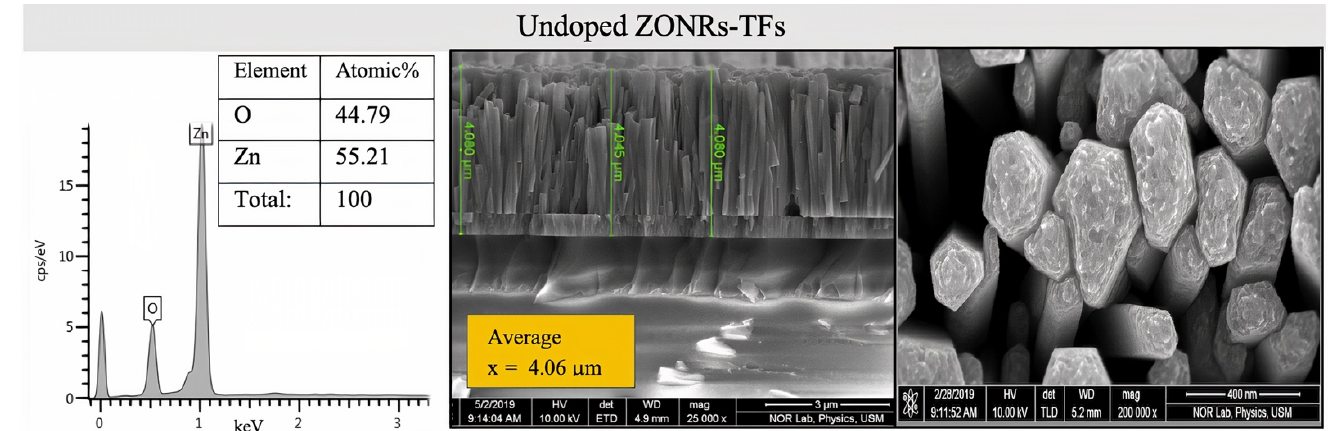
Figure 4. Cross-sectional FESEM images ( right ) and EDX spectra ( left ) of undoped ZONRs-TFs.